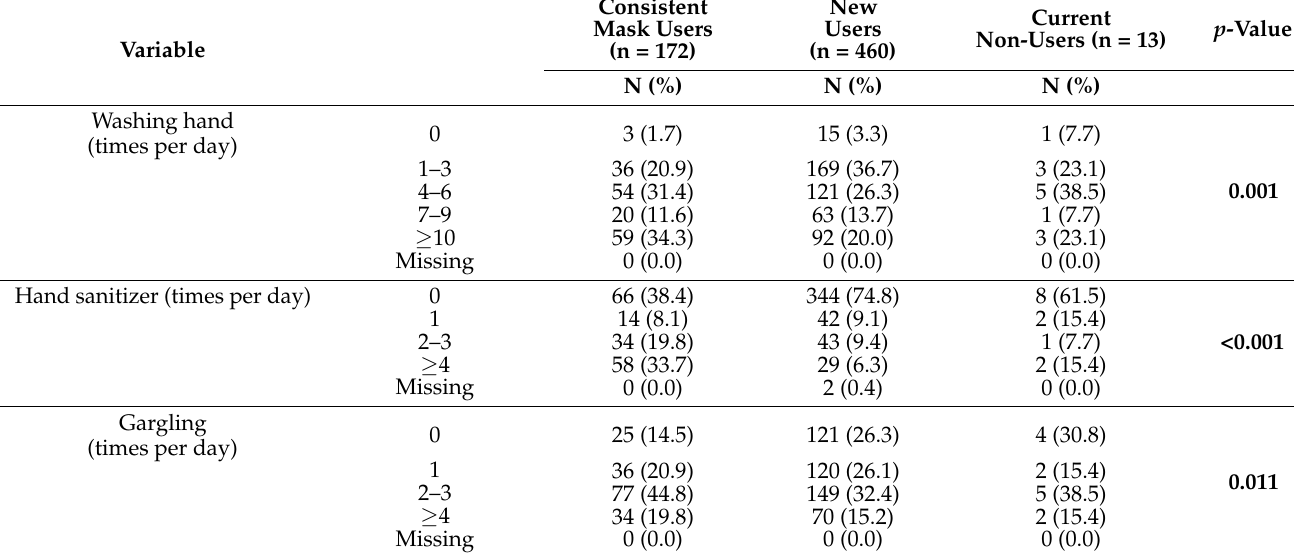
Table 2. Average frequency of use of hygiene measures per day in a typical 2-week period before the pandemic by mask use behavior (n =